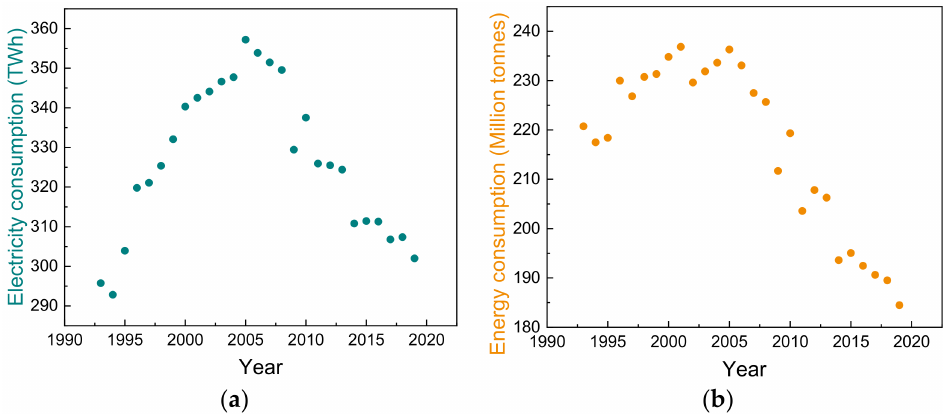
Figure 3. Variations of original data for output variables in 1993–2019. (( a ) electricity consumption; ( b ) energy